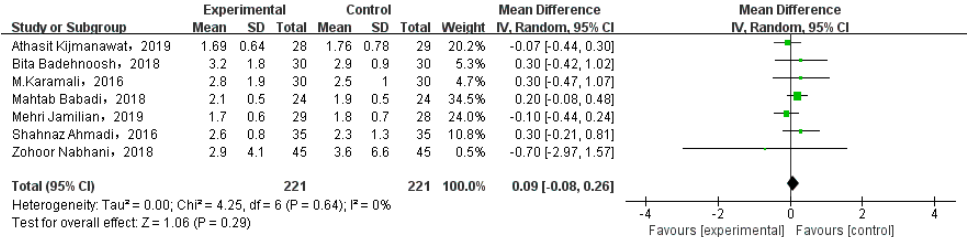
Figure 7. Effect of probiotic supplementation on gestational weight gain in pregnant women with GDM.